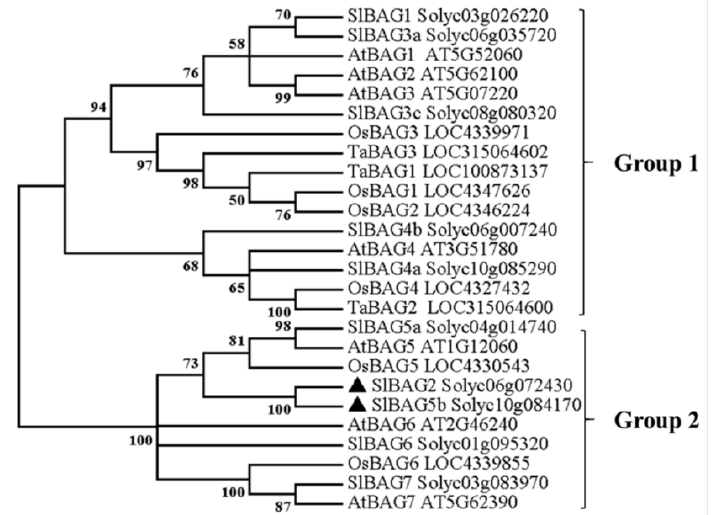
Figure 2. Phylogenetic tree of tomato BAG and BAG proteins from other species. Solanum lycopersicum (Sl), Arabidopsis thaliana (At), Oryza sativa (Os), Triticum aestivum (Ta). Based on the phylogenetic tree, these genes were divided into two groups. The black triangles represented SlBAG2 and